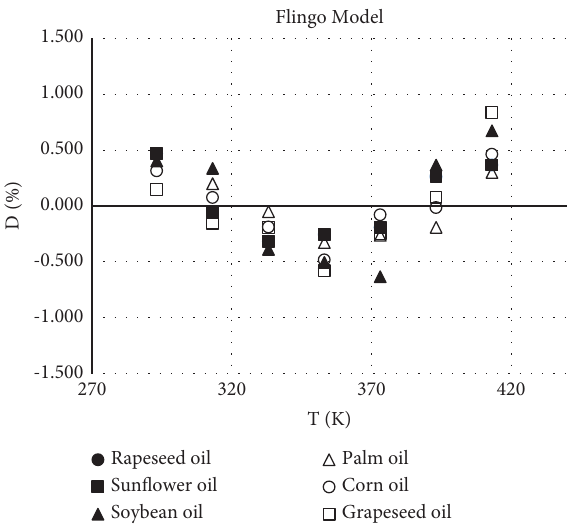
Figure 3: Relative deviations (% Δ ) between the surface tension of the Flingo model by equation (1) and the experimental values reported by Esteban et al. [8].